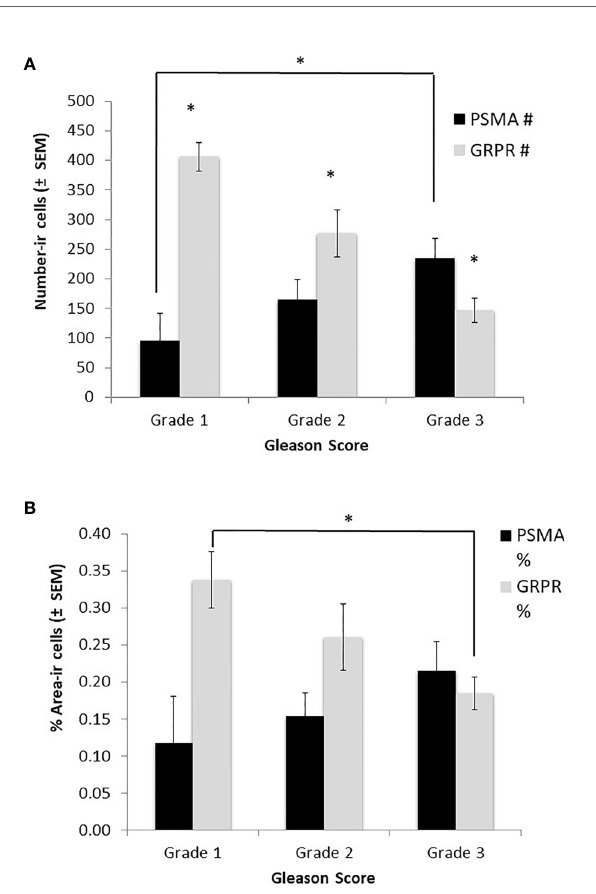
FIGURE 2 | Negative correlation between the expression of the markers PSMA and GRPR. (A) Correlation between the numbers of cells expressed (immunoreactive); (B) Correlation between the % of area expressed.